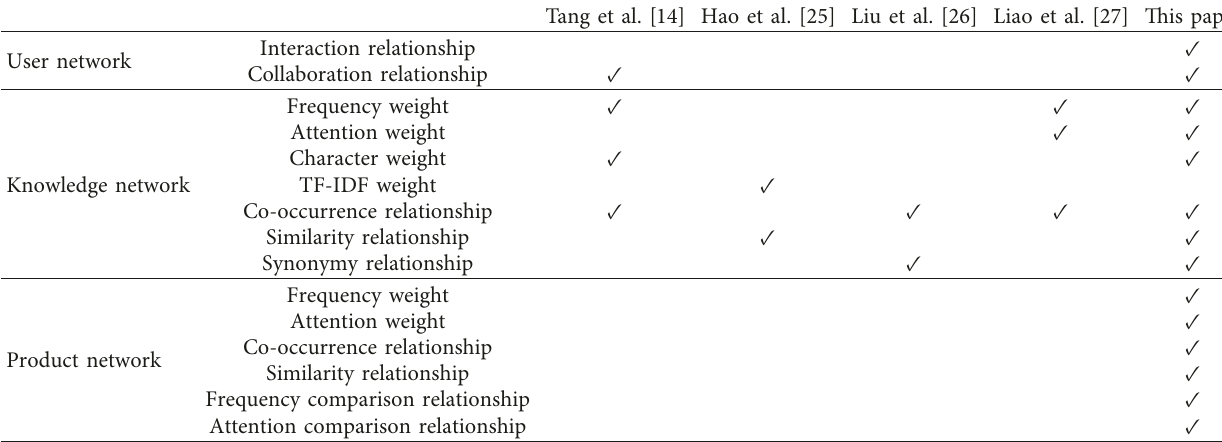
Table 9: Comparison with relevant